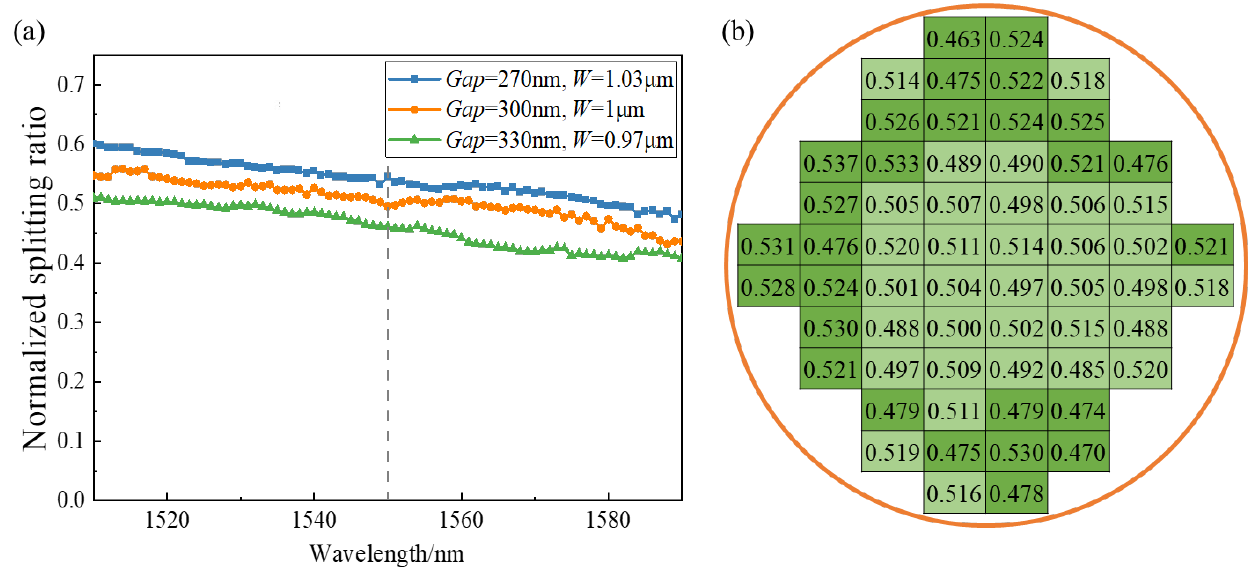
Figure 7. ( a ) Wavelength dependence of transmission of bent DC (cross port) with different sizes; ( b ) wafer-level measurements of splitting ratio at cross port of bent DC.